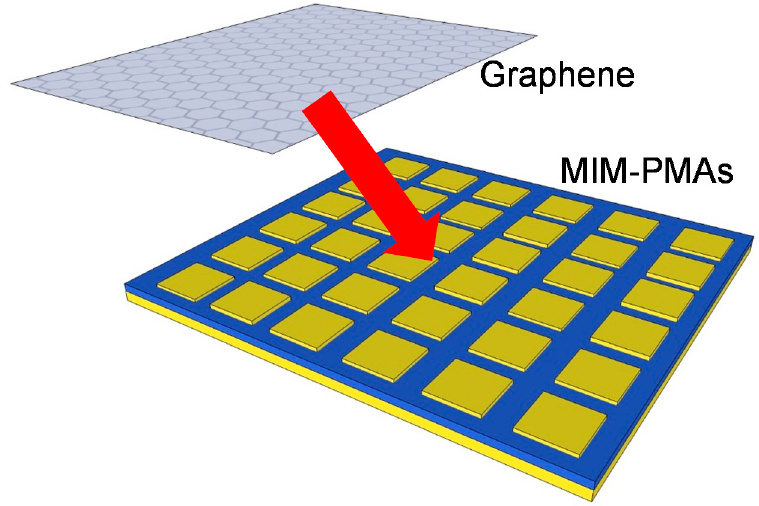
Figure 11. Schematic illustration of a graphene ‐ coated MIM ‐ PMA.